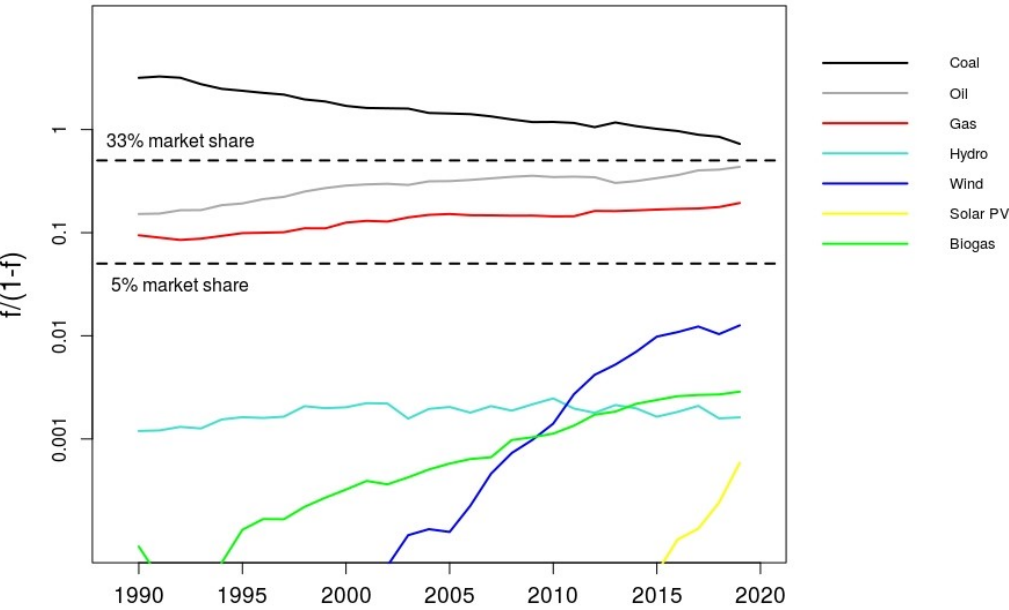
Figure 14. Market shares of energy technologies f between (1990–2019). Source of data: EUROSTAT [38].